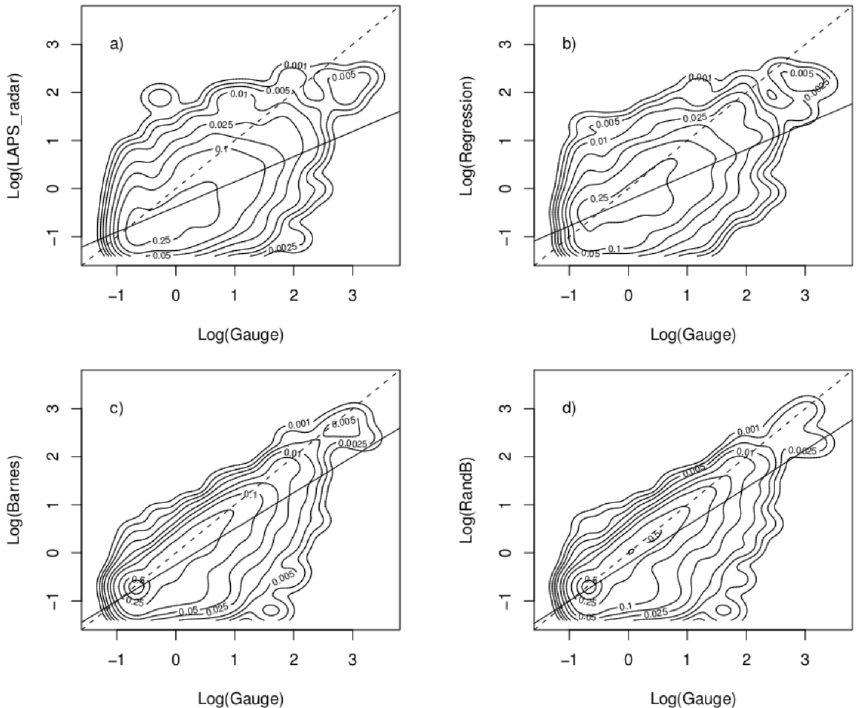
Fig. 4. Density plots of analyzed precipitation accumulation ( y axis) plotted against rain-gauge values ( x axis), for the seven independent stations: (a) LAPS_radar; (b) Regression; (c) Barnes, and (d) RandB. The continuous line is a linear fit to the data set and the dashed line represents the perfect 1 : 1 fit in the